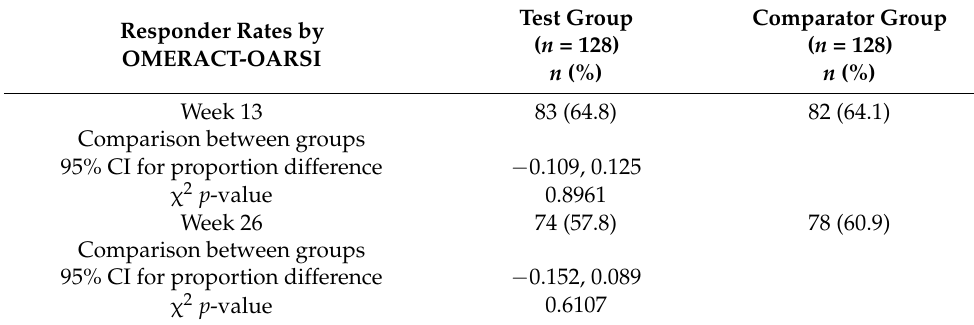
Table 2. Responder rates by OMERACT-OARSI (per-protocol set).